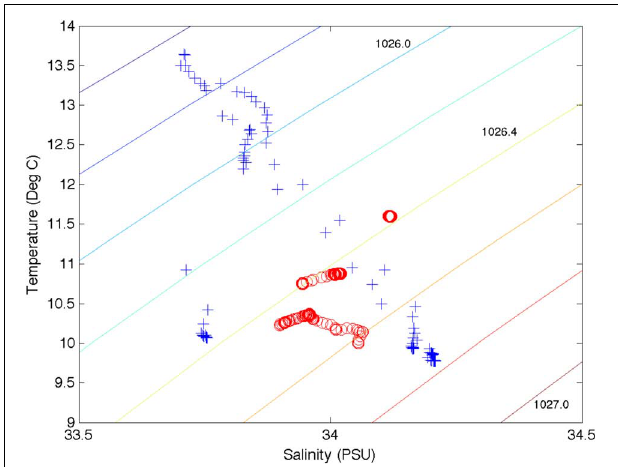
FIGURE 10 | T/S diagram from three profiles from New England in January (red circles) and three profiles north of Cape Hatteras (blue crosses) in April 2017. Note that the New England water mass properties fall in the middle of the three outermost profiles inside the shelfbreak from the cross-shelf transect of the R/V Neil Armstrong on April 25, 2017. Isopycnals are plotted in 0.2 kg/m 3 increments, with a value of 1025.6 km/m 3 in the upper left corner and 1027.0 km/m 3 in the lower right corner.